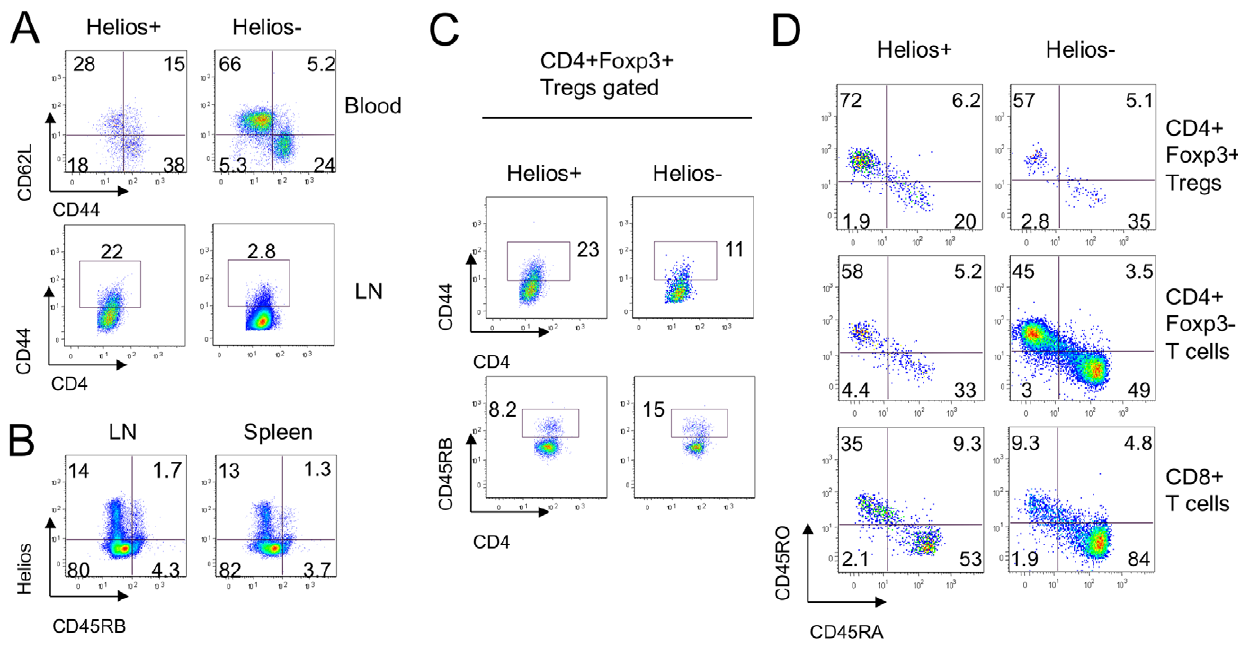
Figure 2. Helios- cells appeared more naı¨ve than Helios + T cells. (A) Expression of CD62L and CD44 in Helios + (left column) and Helios- (right column) gated CD4 + cells in murine blood (top) and lymph nodes (second row). (B) Negative correlation between Helios and CD45RB expression in murine lymph nodes and spleen. (C) Expression of CD44 and CD45RB in Helios + and Helios- gated Tregs in murine lymph nodes. (D) Maturation phenotype in human Tregs (top row), CD4 + Foxp3- Teffs (middle) and CD8 + T cells (bottom row) gated on Helios + (left column) and Helios- (right column) subsets. Data are representative of 4 experiments.